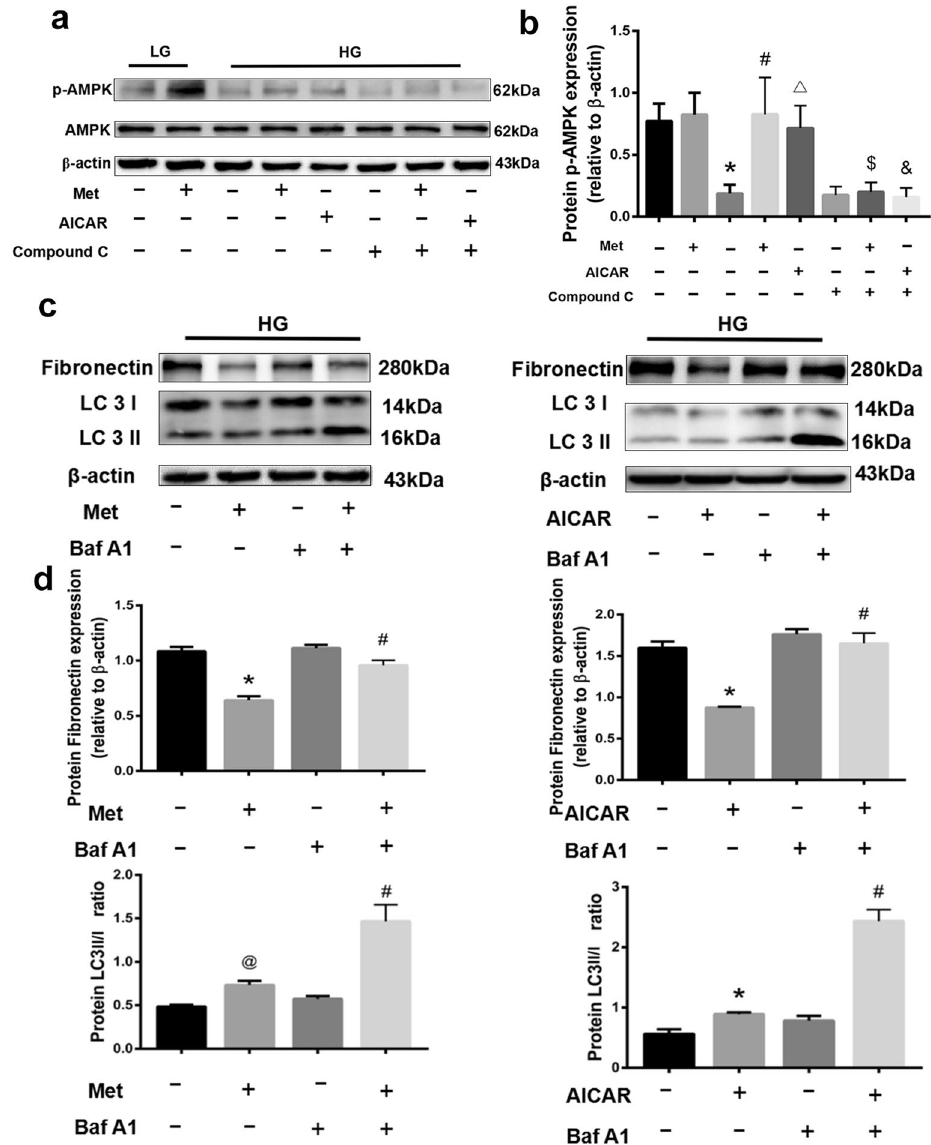
Figure 5. Effects of metformin on the expression of p-AMPK, LC 3I, LC 3II and FN in HG-stimulated RTECs. ( a ) Metformin and AICAR upgraded the p-AMPK expression in HG-stimulated RTECs. The boxes indicate images from different gels. ( b ) Statistical analysis of p-AMPK expression in each group. * P < 0.01 compared with the LG group, # P < 0.01 compared with the HG without metformin group, △ P < 0.01 compared with the HG group, $ P < 0.01 compared with HG + Met group, & P < 0.01 compared with HG + AICAR group. ( c ) Metformin positively regulated the ratio of LC 3II/I and downgraded the expression of FN, while Baf A1 negatively regulated the ratio of LC 3II/I and upgraded the expression of FN. The boxes indicate images from different gels, but the samples derived from the same experiment and blots were processed in parallel. ( d ) Statistical analysis of FN expression and the ratio of LC 3II/I in each group. * P < 0.01 compared with the HG without metformin and Baf A1 group, # P < 0.01 compared with the HG with Baf A1 but without metformin group. Full-length blots were presented in Supplementary